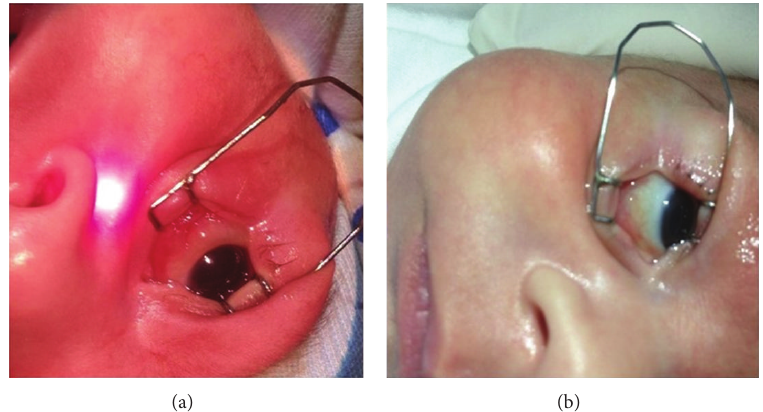
Figure 1: Edema of the inferior fornix conjunctiva and chemosis are easily seen before the first laser session in the right eye of the infant (a). Conjunctivitis is mostly resolved after medical therapy before the second laser session in the same eye